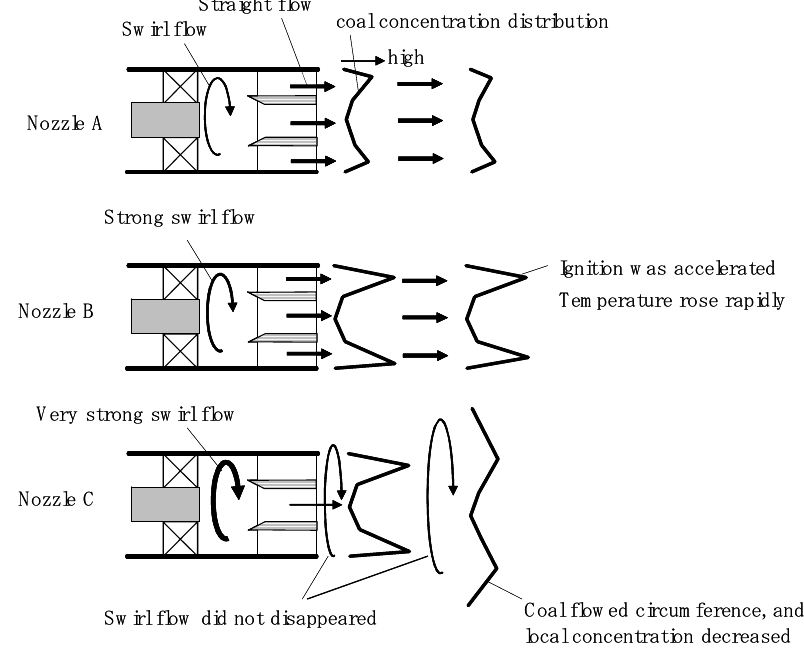
Figure 12. Images of flow and coal concentration distributions near the burner exit for Nozzles A, B and